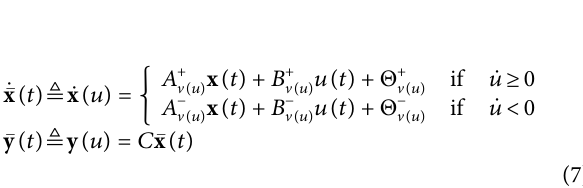
FIGURE3| Thehysteresisloopdescribingthetranslationofthetipofthe soft robot in Y direction.